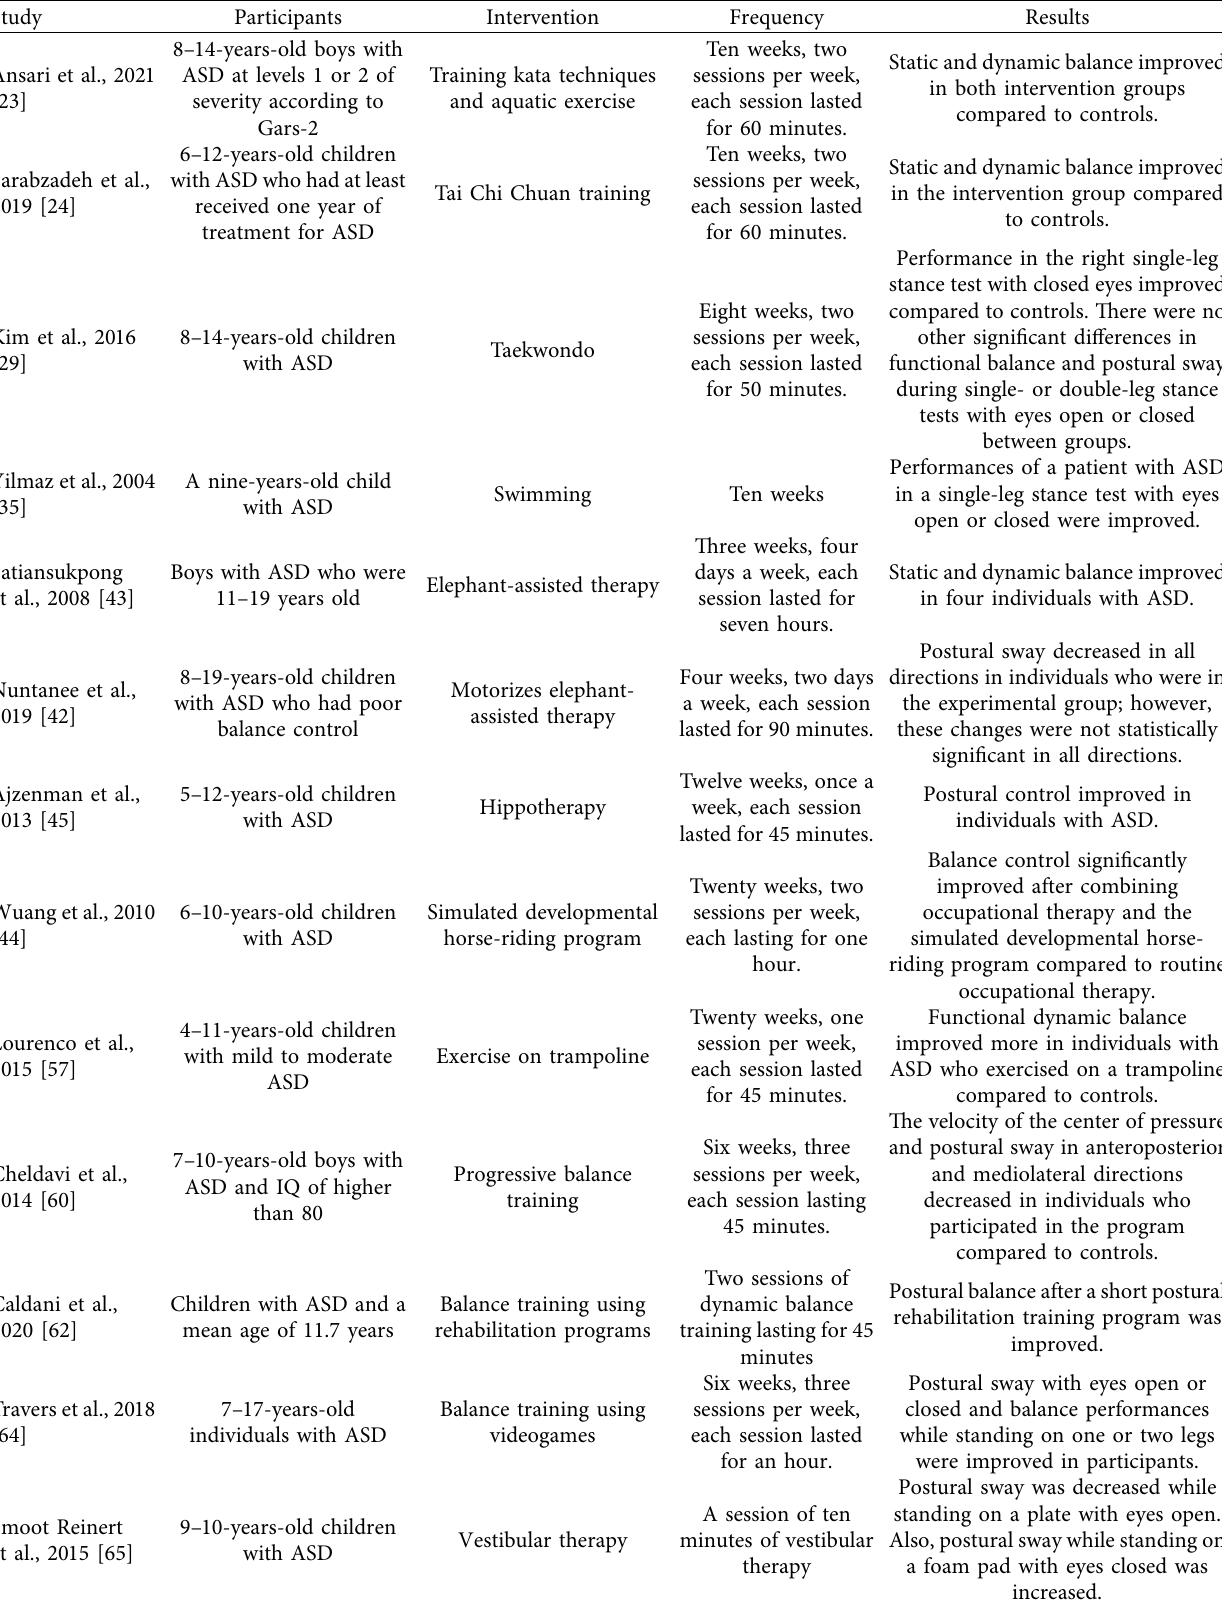
Table 1: Summary of studies evaluating the efects of physical interventions on balance performance in